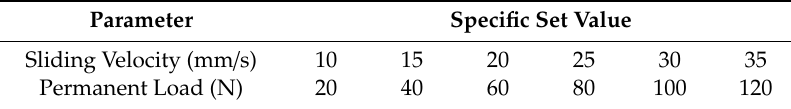
Table 1. Specific setting values of sliding velocity and constant load.